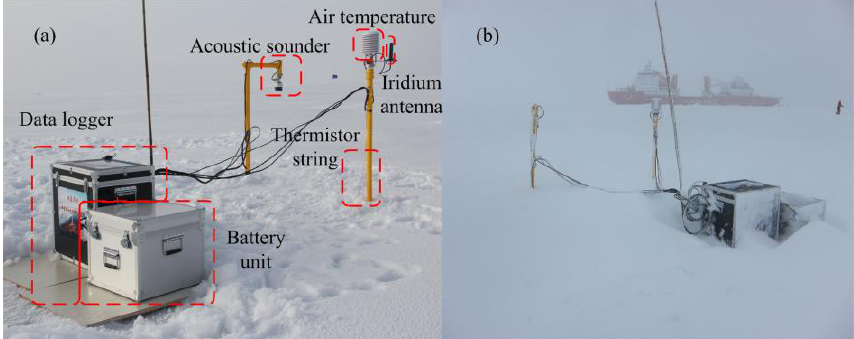
Research Expedition. ( b ) Scene after three days of observing-system